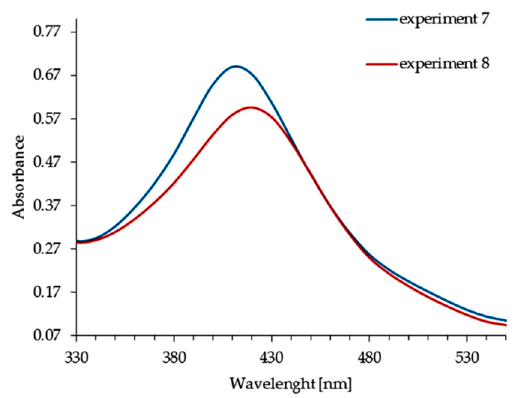
Figure 6. UV-Vis spectra of silver nanoparticles stabilized with 16-6-16 obtained in procedure with excess of reductant.